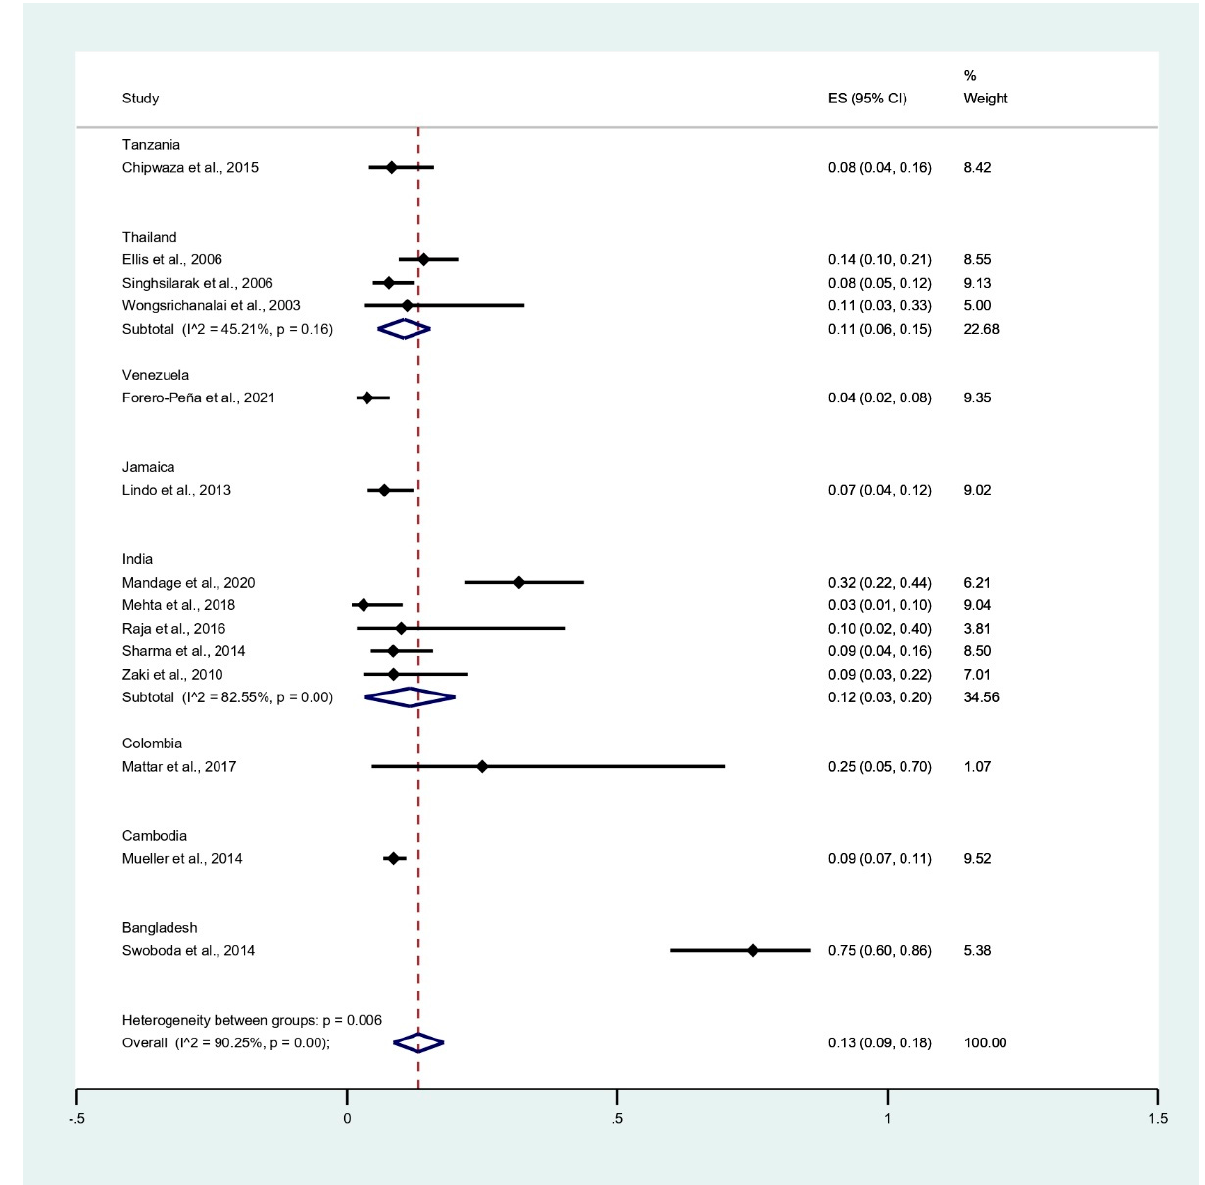
Figure 5. Prevalence of leptospirosis infection among malaria patients by country. % Weighted: the impact proportion of each study to the pooled effect; black dot symbol on black horizontal line: point estimate for each study; black horizontal line: CI, white diamond symbol: pooled prevalence; CI: confidence interval; ES: effect size (prevalence).